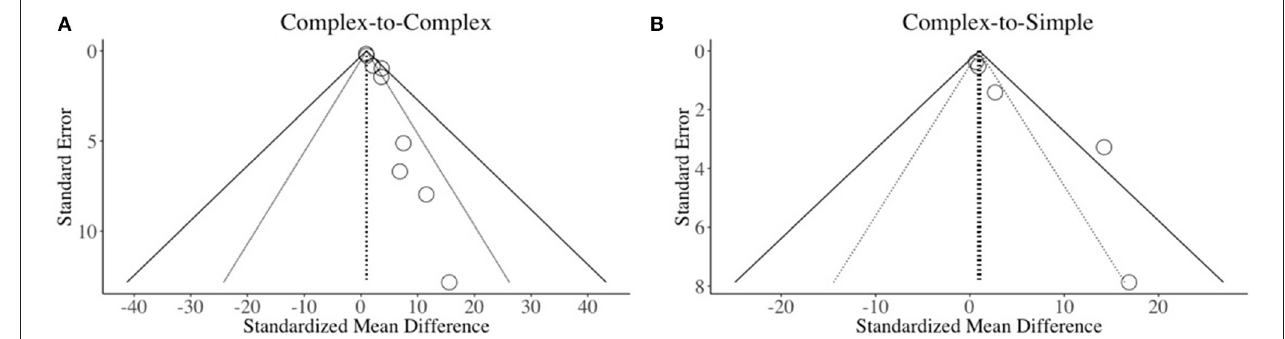
FIGURE 4 | Funnel plots of different conditions. Dotted lines ( ····· ) represent 95% CI while striped lines (–) represent 99% CI. Open circles (o) represent effect sizes plotted against standard error. (A) Complex-to-Complex: Effect of complex stimuli on treated complex speech sounds; (B) Complex-to-Simple: Effect of complex stimuli on untreated simple speech